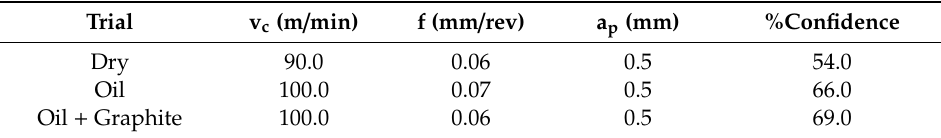
Table 10. Results of the application of the desirability optimization function.